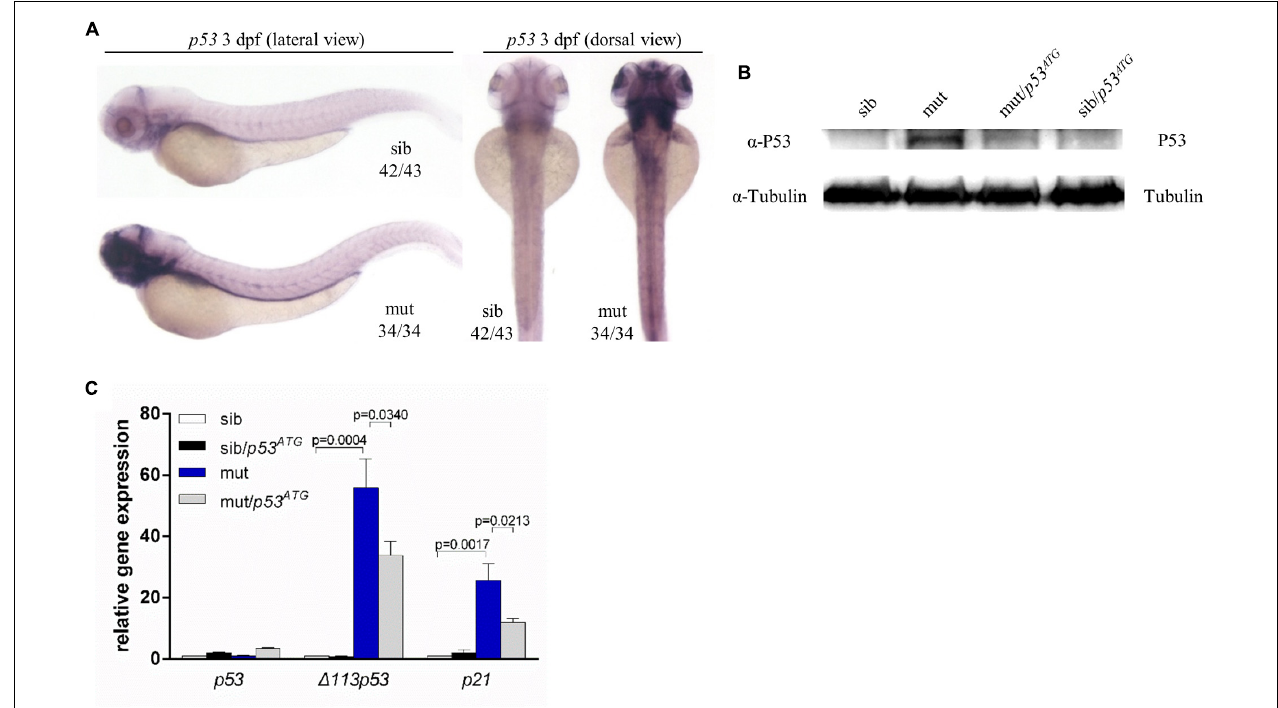
FIGURE 7 | P53 Independence of phenotypes in ltv1 ∆ 14 /∆ 14 mutant. (A) WISH of p53 probe for detecting both p53 and (cid:49) 113p53 at 3 dpf. (B) Western blot results of P53 protein of p53 ATG MO-treated or MO-untreated mutants and siblings at 3 dpf. (C) Evaluation of expression of p53 and its transcriptional targets (cid:49) 113p53 and p21 by quantitative